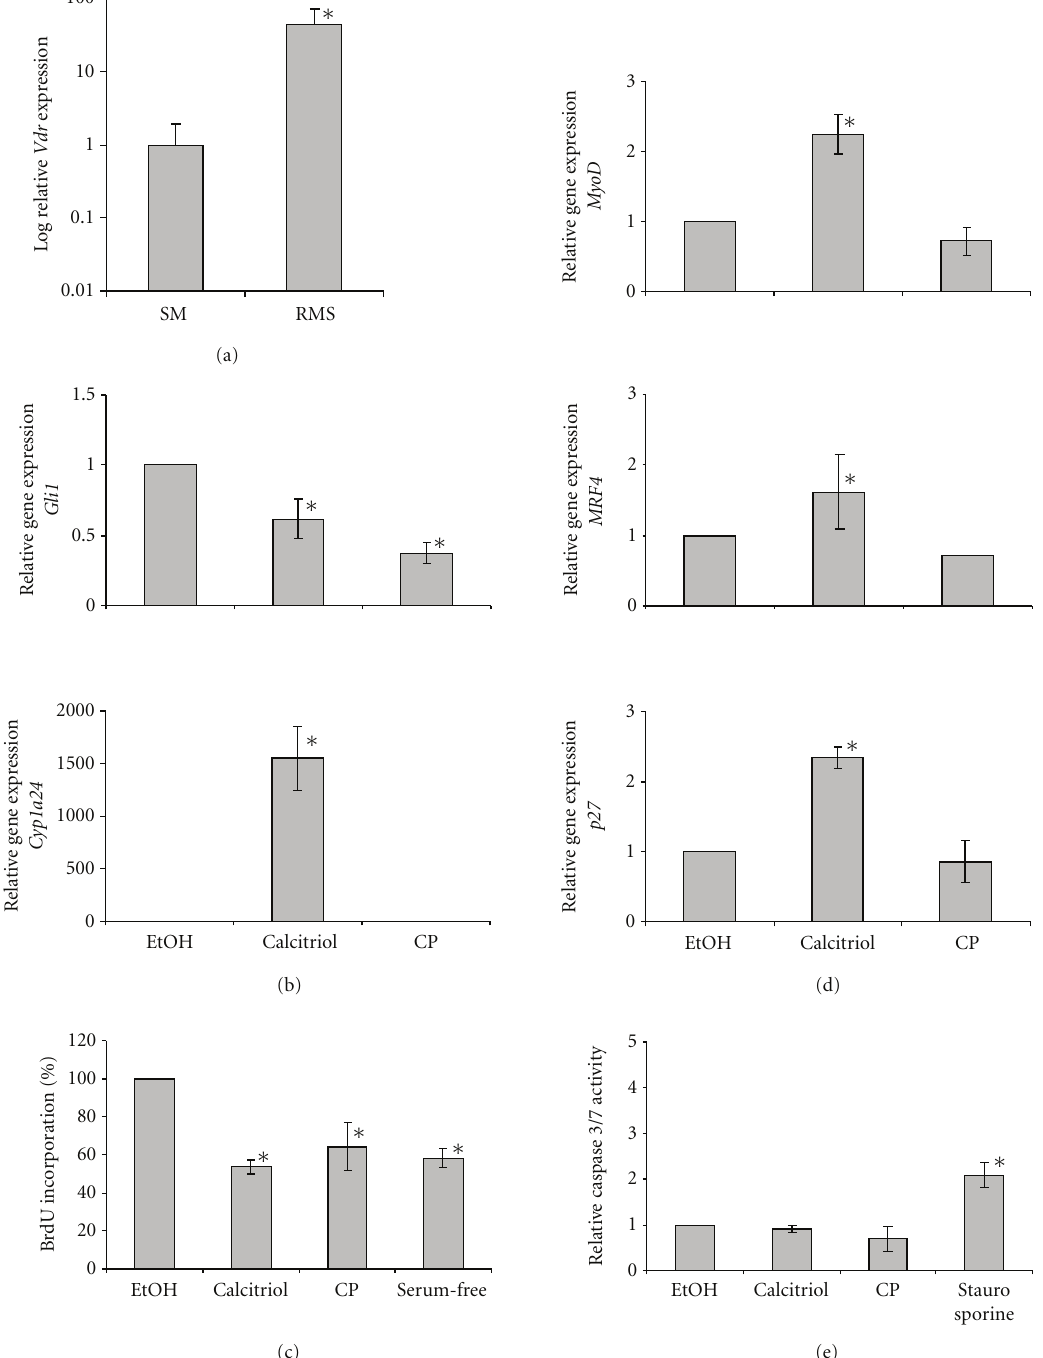
Figure 1: Calcitriol inhibits Hh signaling and proliferation and induces Vdr signaling and di ff erentiation of primary ERMS cultures of Ptch neo67/+ mice. (a) Vdr expression levels of ERMS ( n = 8) compared to normal skeletal muscle (SM; n = 8). (b) Gli1 and Cyp24a1 expression levels and (c) BrdU incorporation of primary ERMS cultures after treatment with vehicle (EtOH), calcitriol, or cyclopamine (CP). (d) MyoD1 , MRF4 , and p27 expression levels and (e) activity of caspase 3 and 7 of primary ERMS cultures after treatment with EtOH, calcitriol or CP. Values of vehicle-treated controls for Gli1, MyoD1 , MRF4 , and p27 expression were set to 1. Expression levels were normalized to the expression of 18S r RNA gene. For BrdU incorporation or caspase 3/7 assays, cells treated with serum-free medium or 500nM staurosporine (Sigma-Aldrich) served as positive controls, respectively. The values of BrdU incorporation and caspase 3/7 activity represent the percentage of respective vehicle-treated control, which was set to 1. Asterisks: P < 0 . 05; error bars: mean ±